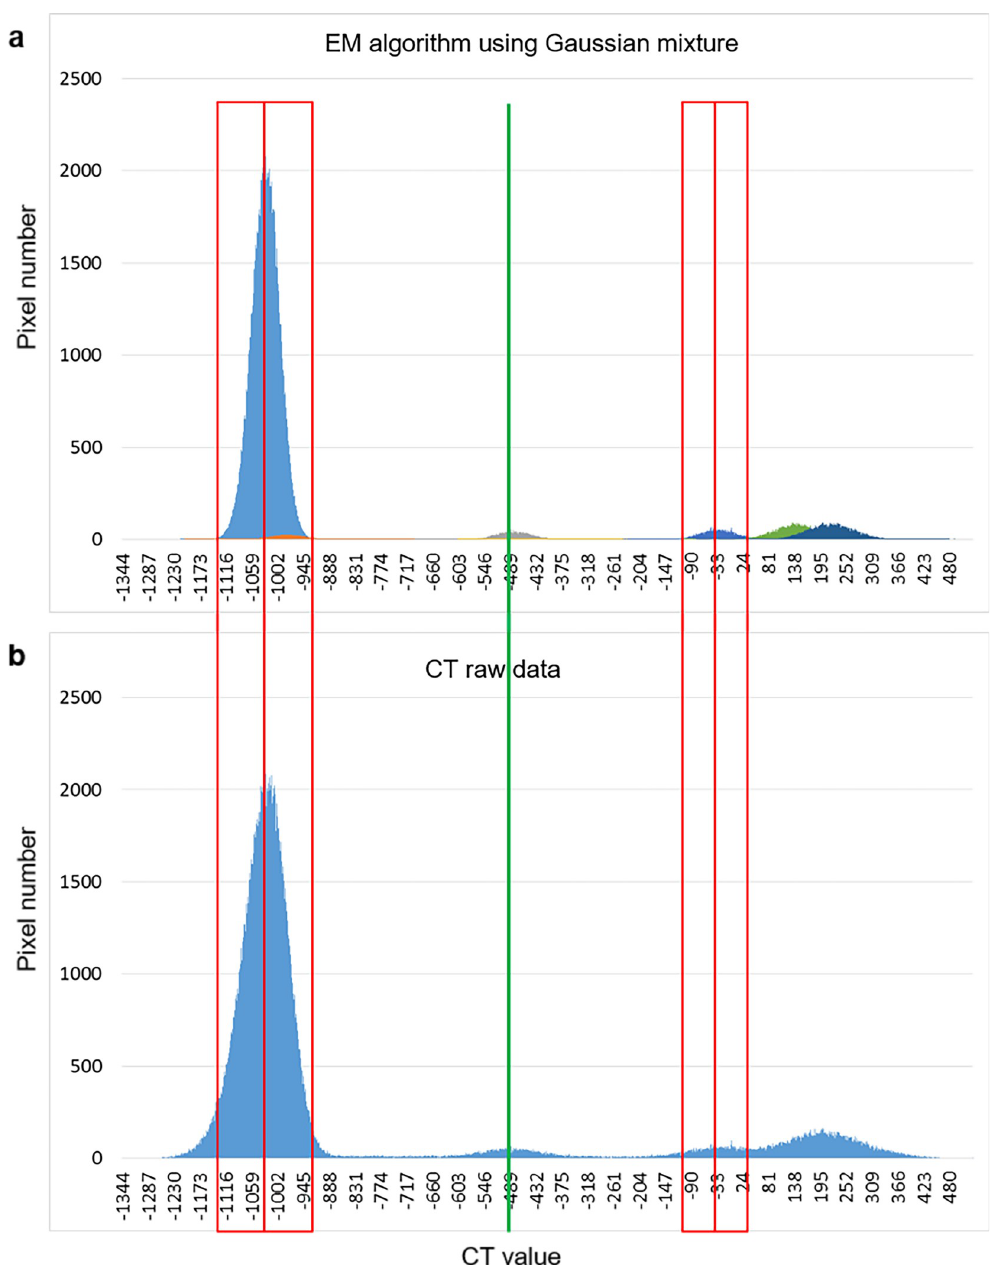
Fig 5. Expectation-maximization (EM) algorithm using Gaussian mixtures for auto-thresholding of the polyvinylsiloxane (PVS) impression. (a) The threshold of PVS impressions found using the EM algorithm, (b) the raw data of computed tomography values before using the EM